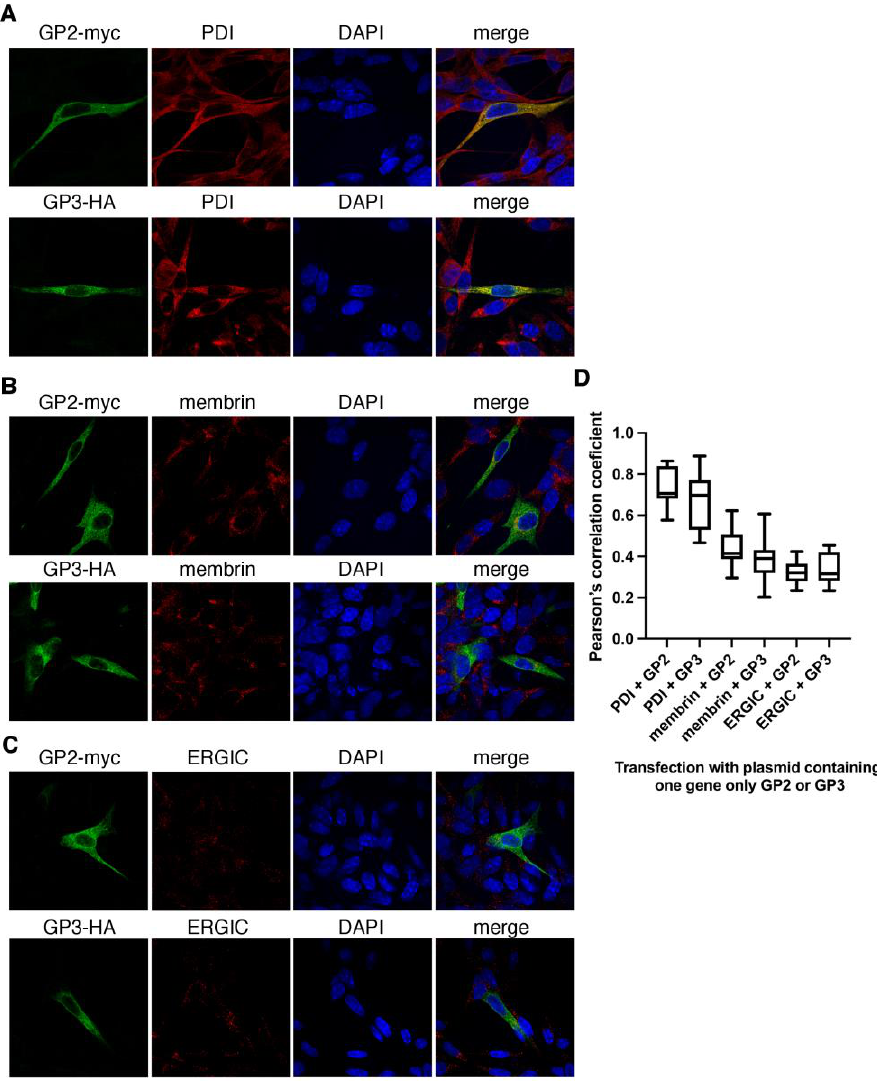
Figure 8. When expressed separately, GP2-myc and GP3-HA co-localize with ER, and only to some extent with cis-Golgi and weakly with the ERGIC marker. BHK-21 cells were transfected with Gp3-HA in pMDS or with GP2-myc in pMDK. ( A ) Cells were fixed 22 h post-transfection and subjected to double staining with antibody against protein tags: anti-myc or anti-HA and the following cellular markers: anti-PDI for endoplasmic reticulum (ER) ( A ), anti-membrin for cis-Golgi ( B ) and anti-ERGIC53 for ER-Golgi intermediate compartment (ERGIC) ( C ). DAPI, a nucleus stain was added to the mounting medium. Graph shows co-localization values for GP2-myc and GP3-HA with compartments marker ( D ). Experiments were performed in duplicates and at least 10 cells per experiments were taken to quantify the co-localization in 3D in Huygens Professional software. Pearson’s correlation coefficients graphs were generated with Prism software (GraphPad Software, San Diego, California, USA).